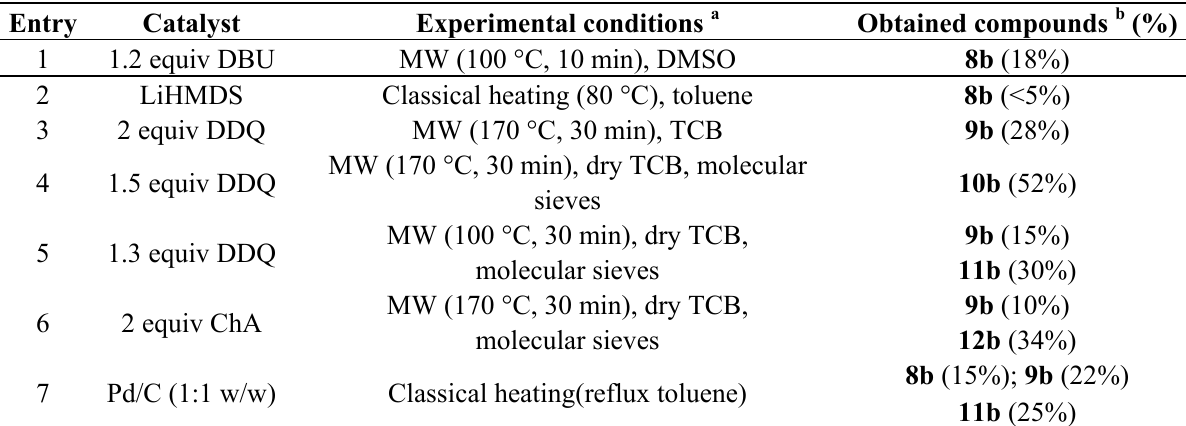
Table 1. Optimization of the aromatization